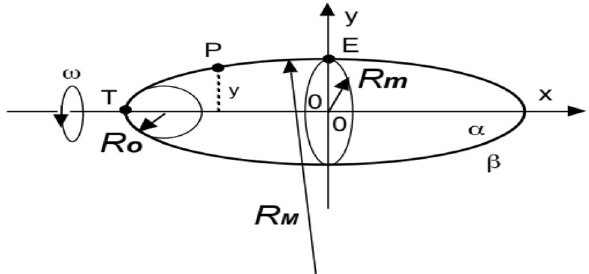
Fig. 4 Geometry of a spinning drops of denser liquid α in less dense liquid